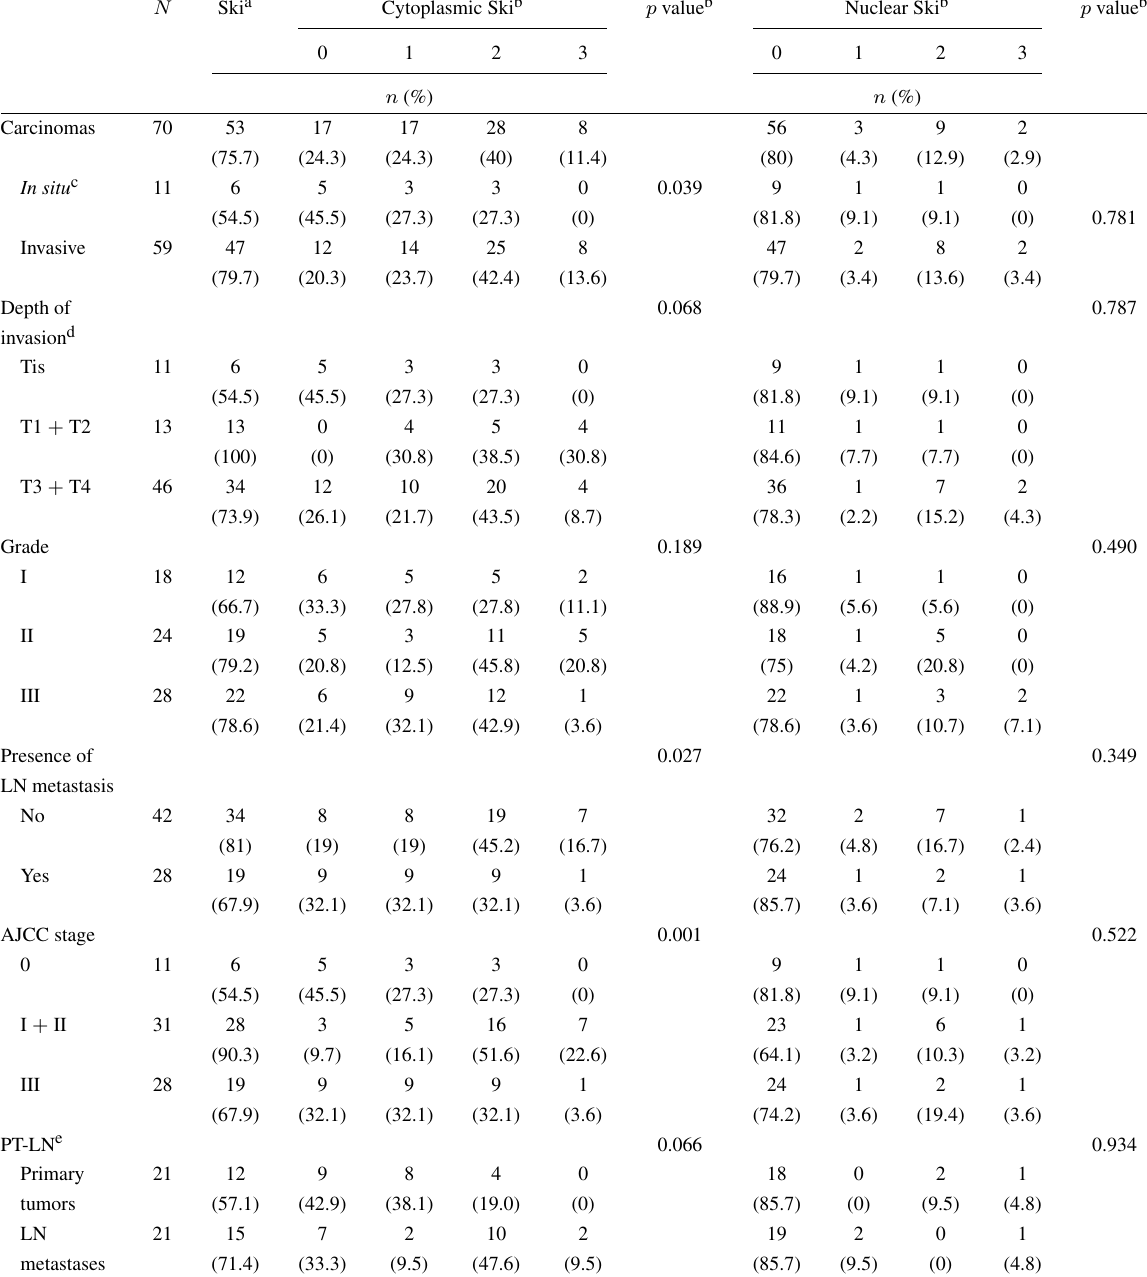
Ski expression in human colorectal carcinomas and lymph node metastases. Correlation with clinicopathological